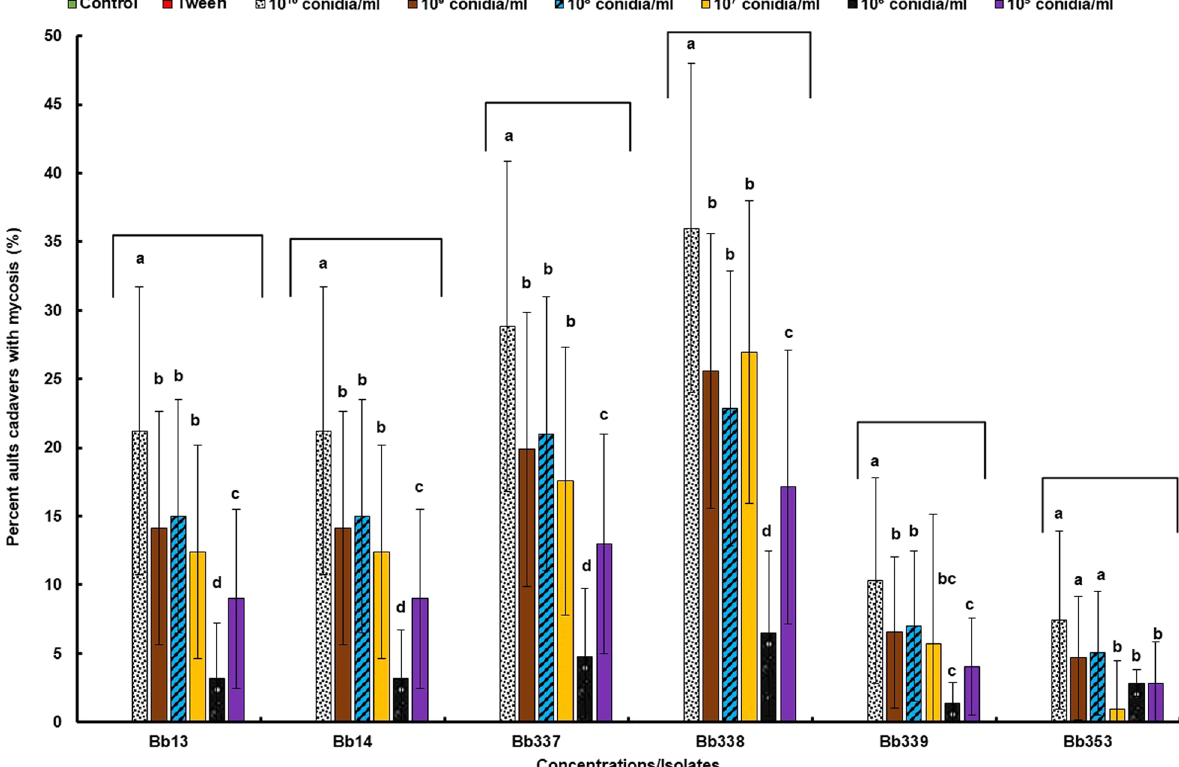
Fig. 9 Cadavers Zeugodacus cucurbitae adults with fungal growth after treatment with different concentrations of isolates of Beauveria bassiana and Metarhizium anisopliae in adult inoculation